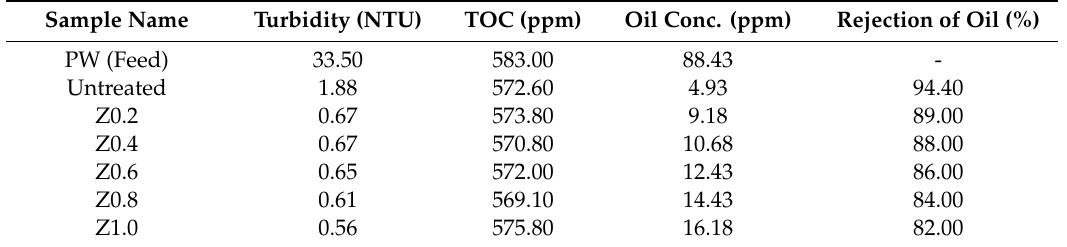
Figure 11. Steady-state pure water and PW permeability for untreated nylon 6,6 NFM and nylon 6,6/ZIF-8 NFM. 3.8. Rejection Analysis From the rejection analysis shown in Table 2, nylon 6,6 NFM incorporated with ZIF-8 gave more than 80% rejection of oil and excellent suspended solid removal shown from turbidity data. Due to its large pore size, NFM incorporated with ZIF-8 was unable to achieve 100% rejection, as some oil droplets smaller than 0.86 µm were able to pass through the membrane pores. Z0.2 NFM has the highest rejection at 89% with oil concentration below 10 ppm, which is able to meet the Malaysia standard B discharge requirement. This is due to its smaller pore size and lower hydrophobicity compared to the other membranes, so less oil molecules can absorb and pass through the membrane. Nevertheless, increasing the loading of ZIF-8 will decrease the selectivity of the membrane. This can relate to the “deswelling effect” where at higher loading of ZIF-8, the pore size of the membrane is maintained at its size, allowing more liquid to penetrate through the membrane. Moreover, there no significant changes could be observed at TOC data. This is because the properties of NFM, which are similar to MF membrane, enables it to only filter large colloids or in this study, dispersed oil inside